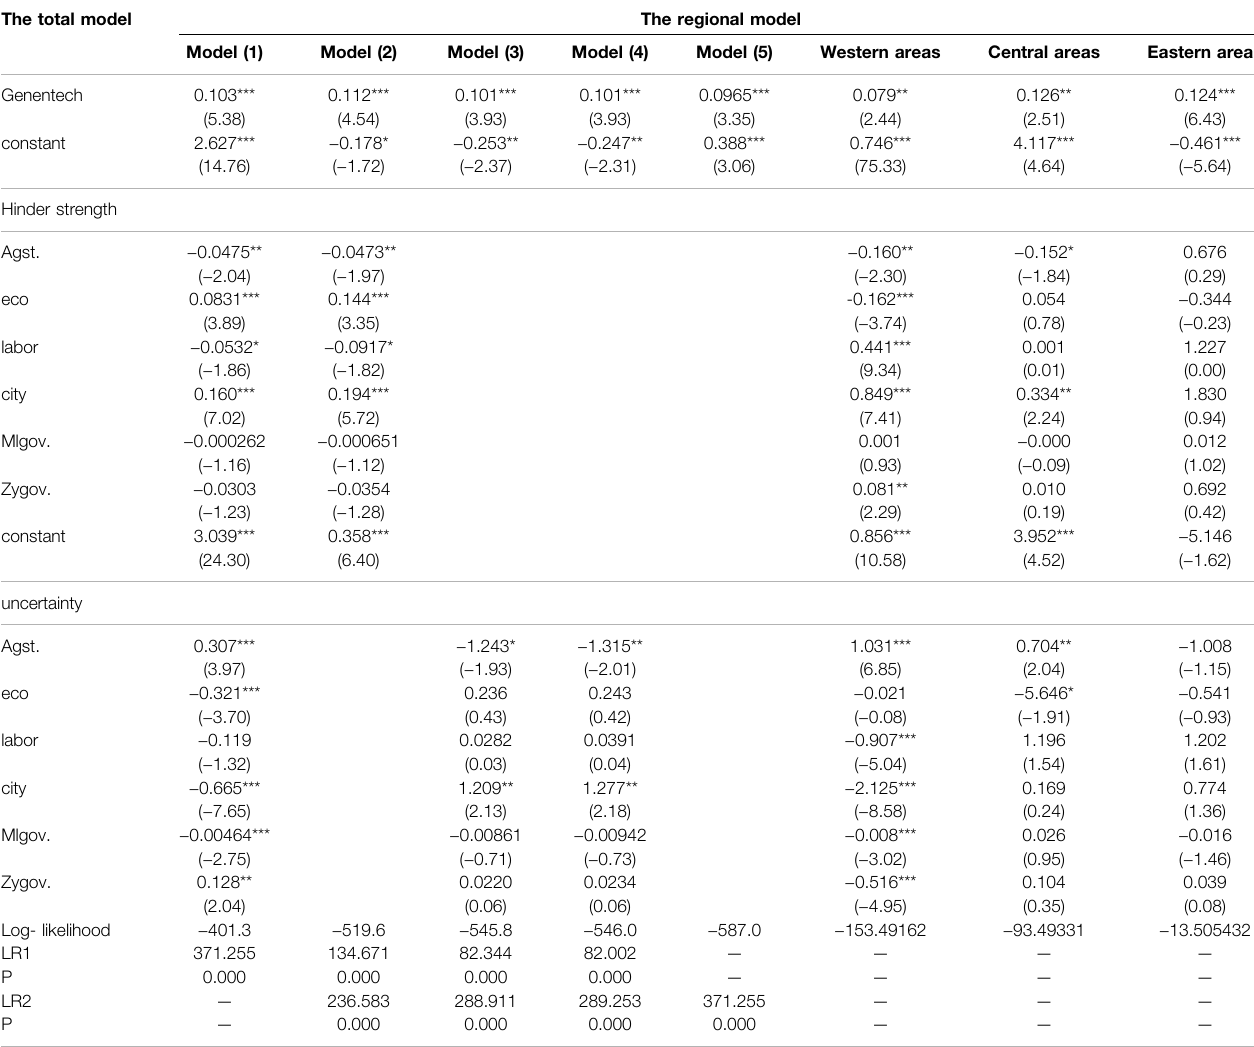
TABLE 2 | Model estimation and test results. The total